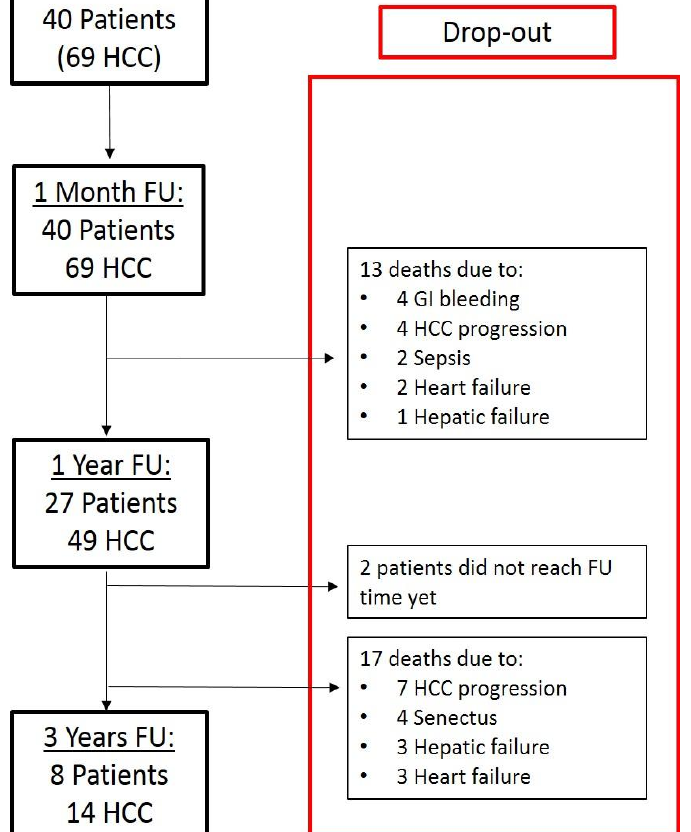
Figure 2. Follow-up in patients submitted to TACE. Four TACE patients died due to HCC progression, five due to liver disease complication/hepatic failure, two from sepsis, and one from heart failure. Three-year OS was 97.4% [IC: 0.891–0.992] in the surgical group and 32.3% [IC 95: 0.1762–0.4802] in the TACE group ( p < 0.0001), as reported in Figure 3.